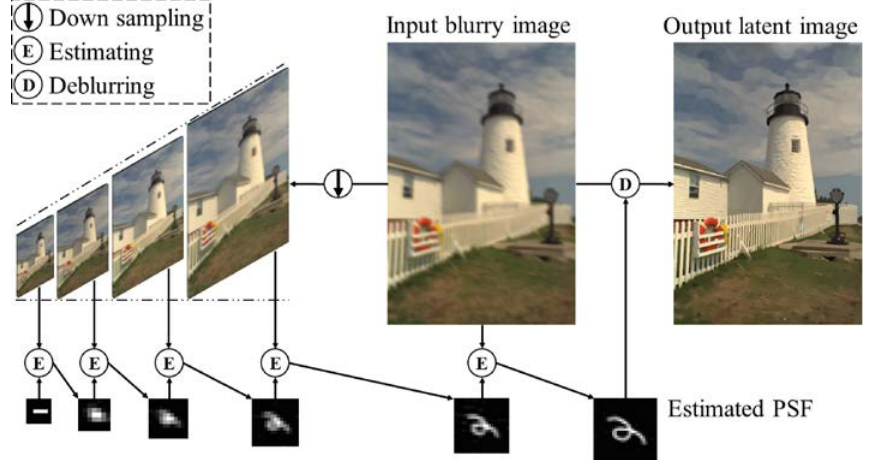
Figure 2. Framework of the proposed method in a coarse-to-fine scheme. The “Down sampling” step is accomplished through the Gaussian pyramid technique; the “Estimating” step is described in Section 2.2; the “Deblurring” step is discussed in Section 2.3.